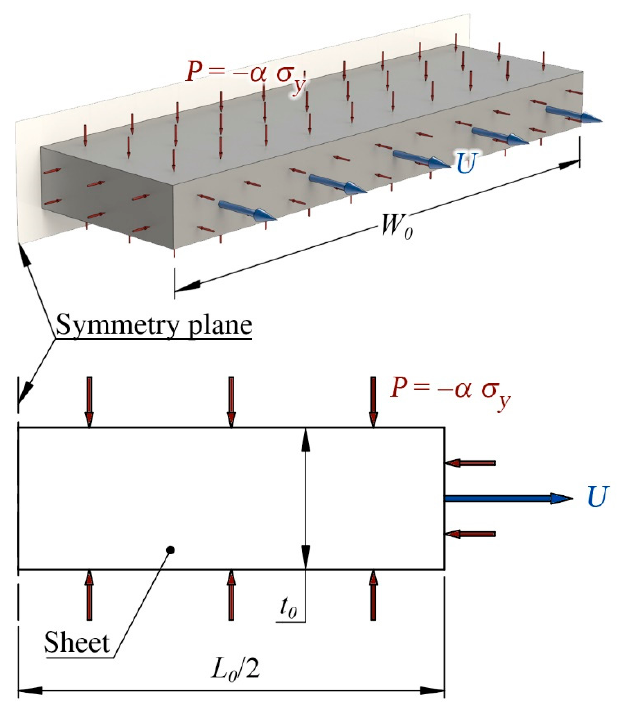
Figure 2. Schematic of a sheet metal under superimposed hydrostatic pressure. The elastic–plastic properties of the matrix material are specified by 𝜎 (cid:3052) 𝐸⁄ = 0.0033 , 𝜈 = 0.3 and 𝑛 = 10 . It is assumed that the initial void volume fraction is zero and the fit